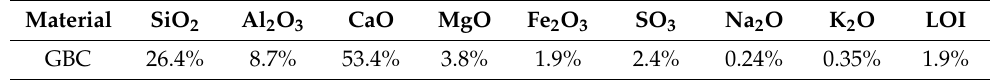
Table 1. Chemical composition of GB cement.